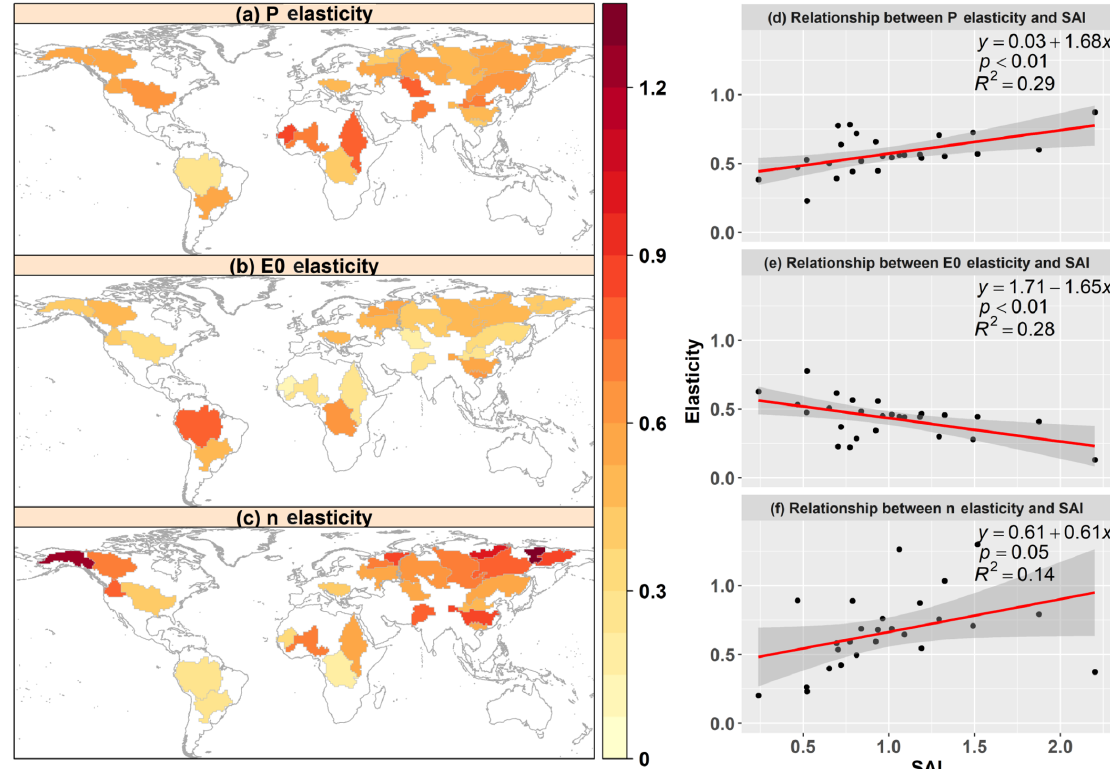
Figure 6. The climatic elasticity of evapotranspiration to the changing precipitation, potential evaporation and other factors represented by controlling parameter n in the 26 global large river basins, and its relations with the climate seasonality and asynchrony index (SAI). Note that each point represents one of the 26 global large